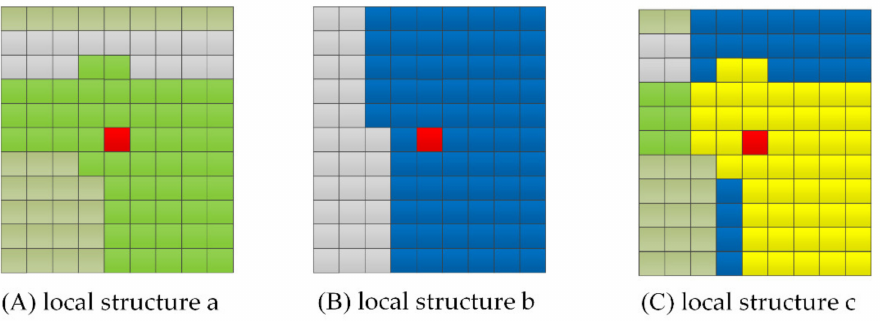
Figure 3. The local structures in superpixels: ( A , B ) are two local structure samples, in which green and blue pixels represent the local structures, and ( C ) denotes the calculation position (yellow pixels) of structures a and